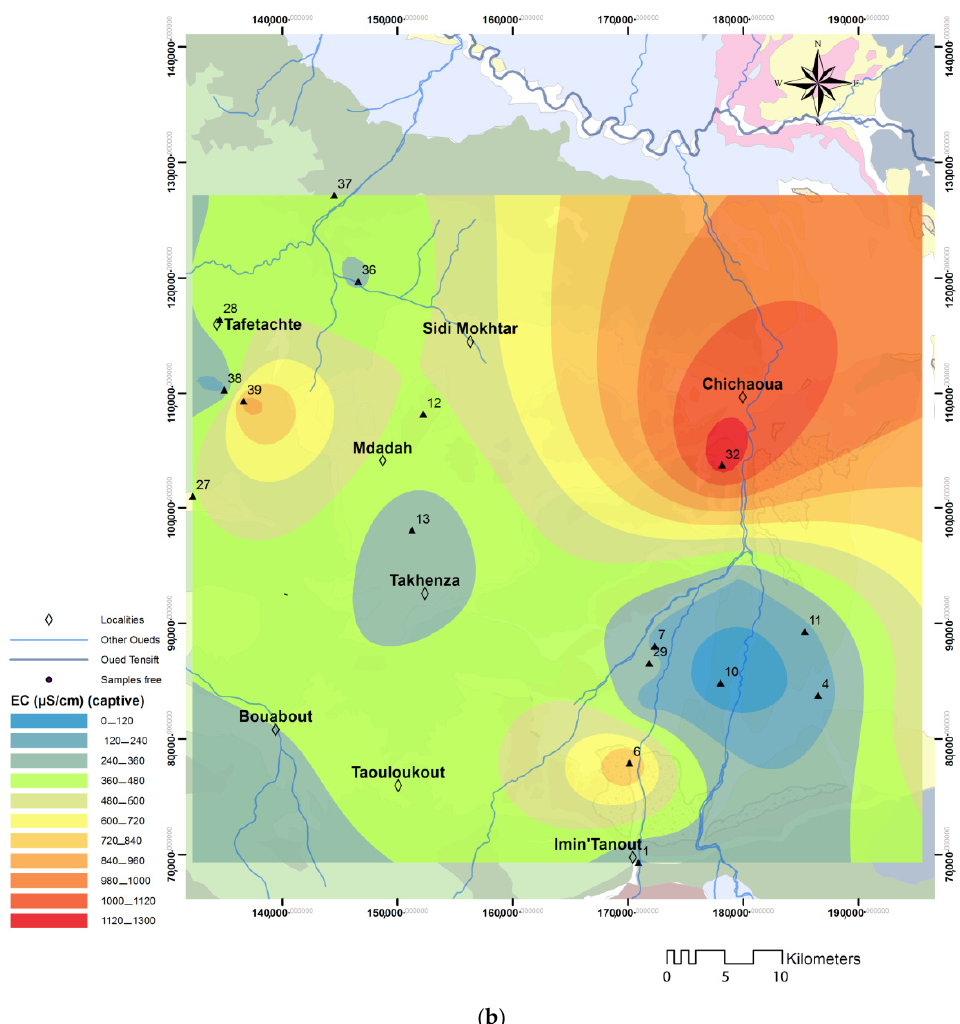
Figure 6. Spatial distribution of groundwater EC in the study area. ( a ) In the free aquifer; ( b ) In the captive aquifer.